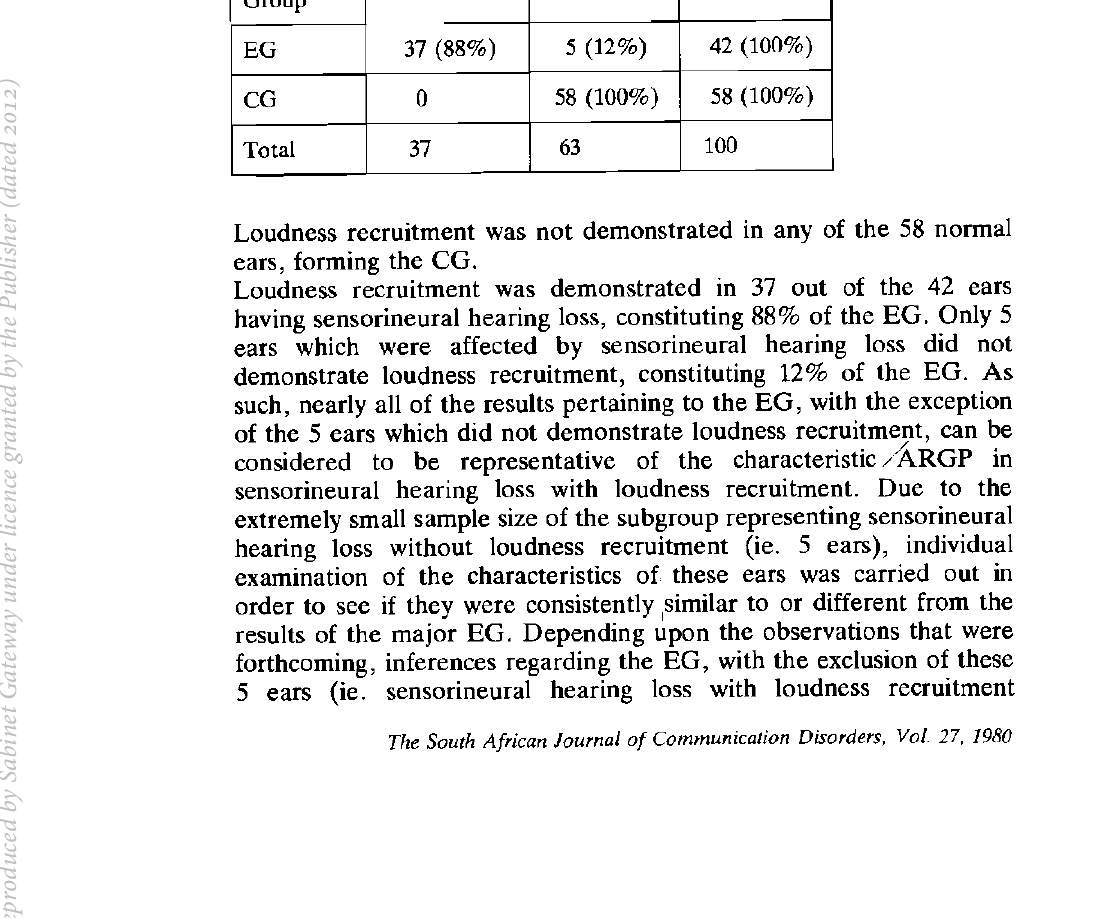
TABLE V: The Frequency of Occurrence of Loudness Recruitment in the EG and